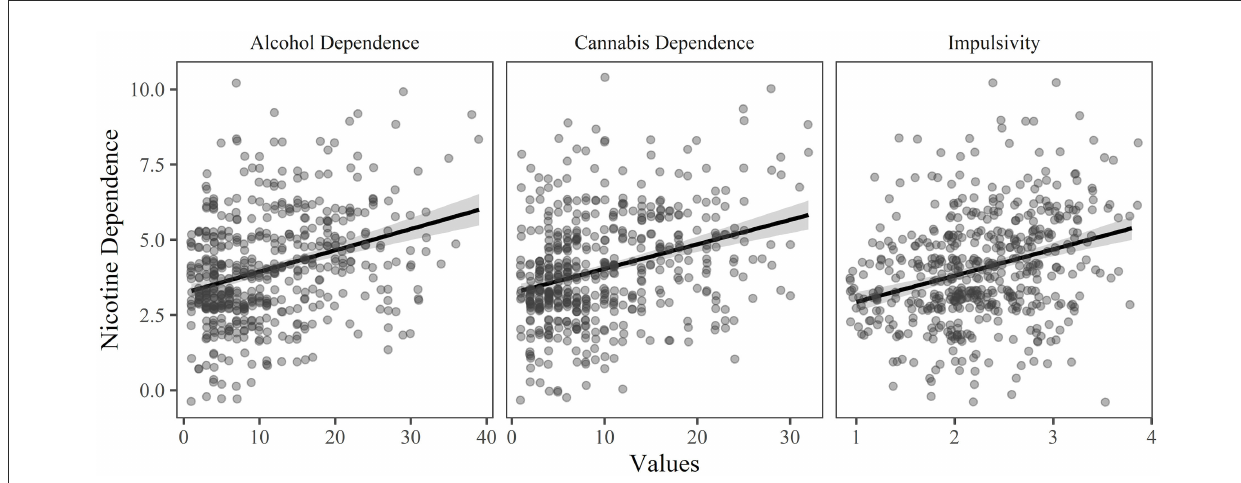
FIGURE3 The relationship between nicotine dependence and each of the significant predictor variables ( p < 0.05 and relative importance ≥ 0.02) in the final model of the hierarchical regression, holding all other variables constant.